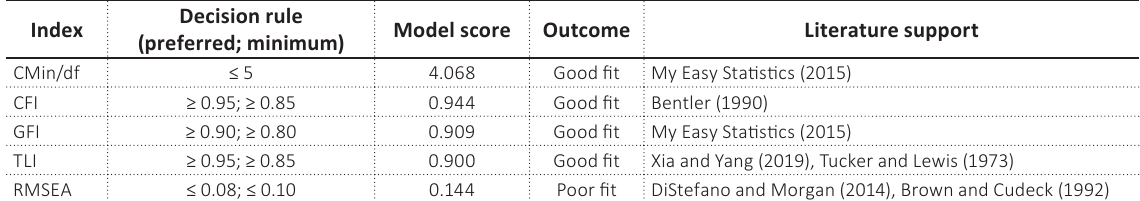
Table 5. Goodness of fit